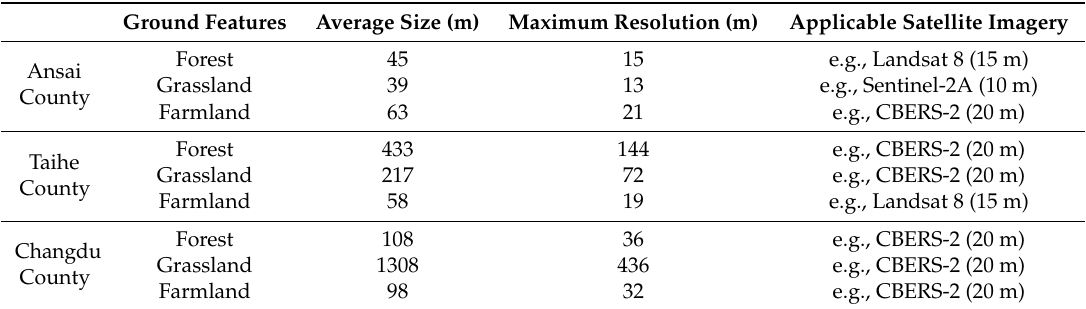
Table 7. Applicable satellite imagery for general ground features in pilot